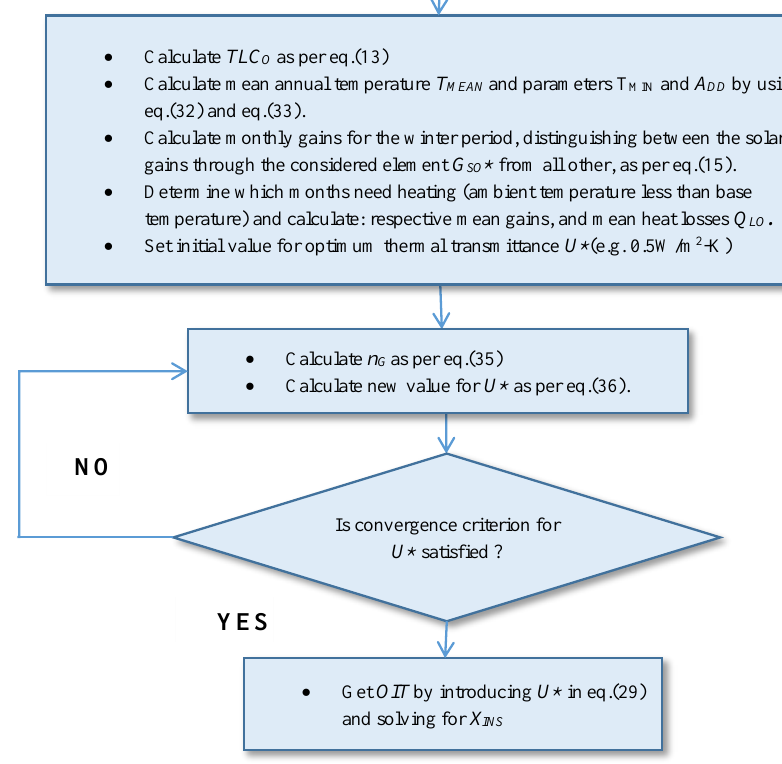
Figure 6. Indicative flow-sheet of the proposed approach.